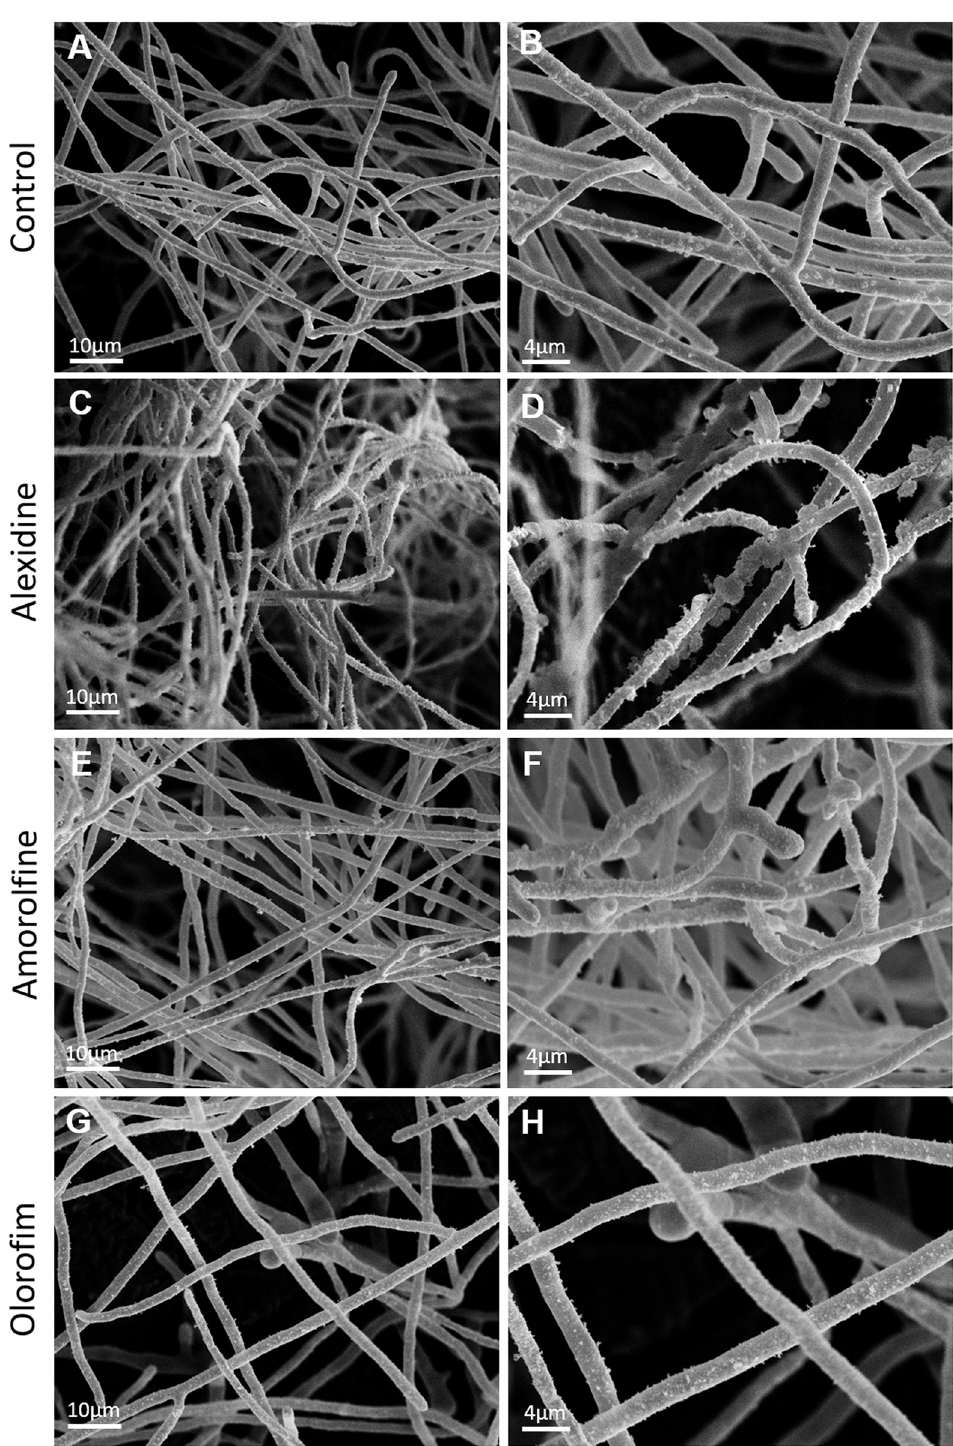
Fig 6. Morphological alterations on S . aurantiacum biofilm by scanning electron microscopy. S . aurantiacum CBS 136046 preformed biofilm was incubated in the presence of alexidine, amorolfine or olorofim for 24 h at 37˚C. Untreated cells were used as a control. Bars: 10 μ m (A, C, E and G) e 4 μ m (B, D, F and H).